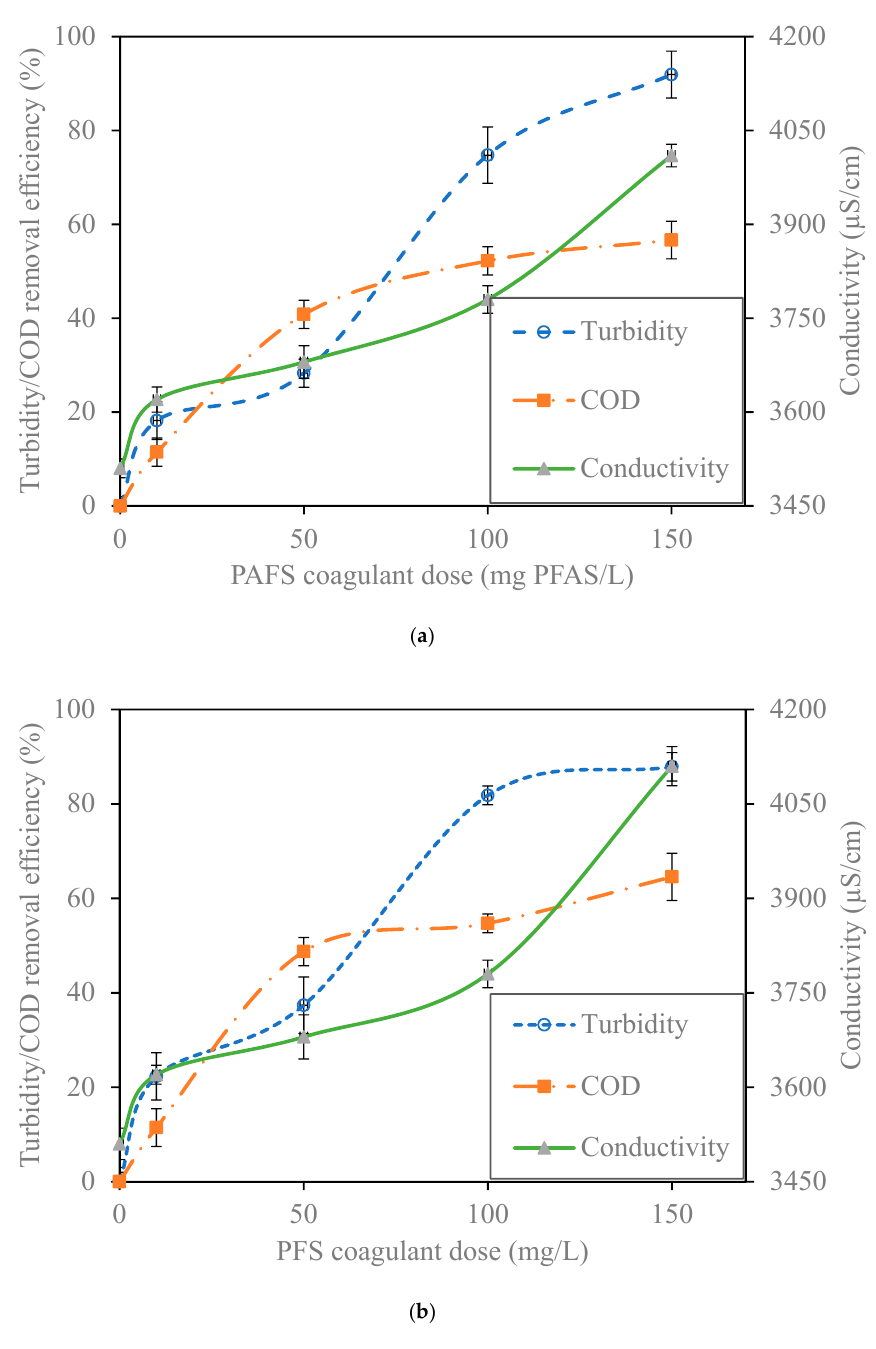
Figure 4. Performance evaluation of ( a ) poly-alumino-ferric sulphate (AMD-PAFS) coagulant and ( b ) poly ferric sulphate coagulant (initial pH 7.0, temperature = 24.6 °C) during the treatment of brewery wastewater .